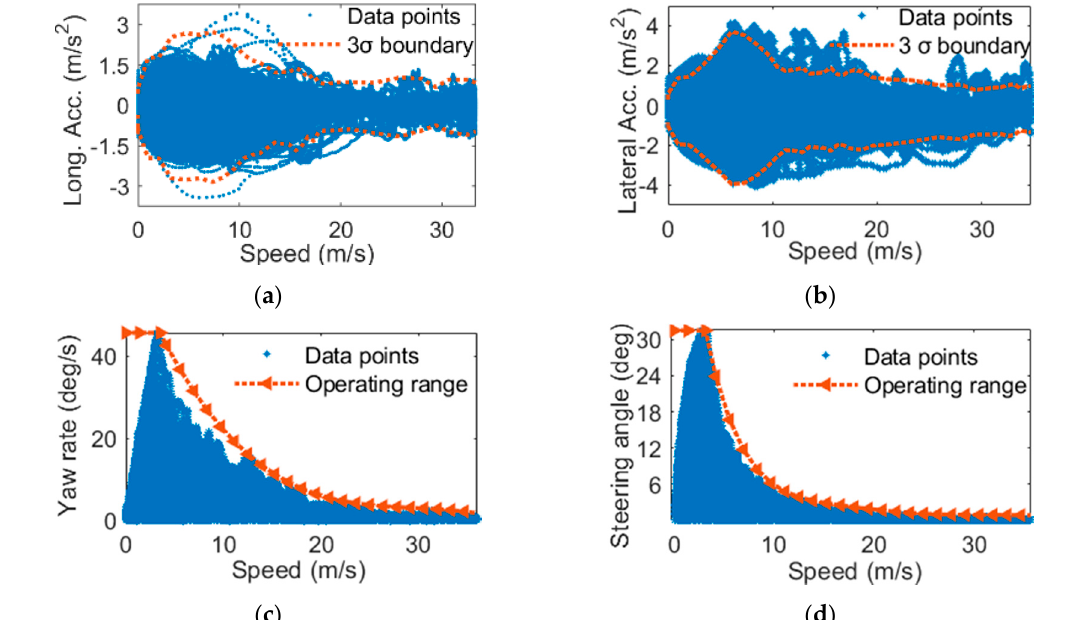
Figure 2. Statistical results of natural driving data. ( a ) Longitudinal acceleration distribution. ( b ) Lateral acceleration distribution. ( c ) Yaw rate distribution. ( d ) Steering angle distribution of front tire.